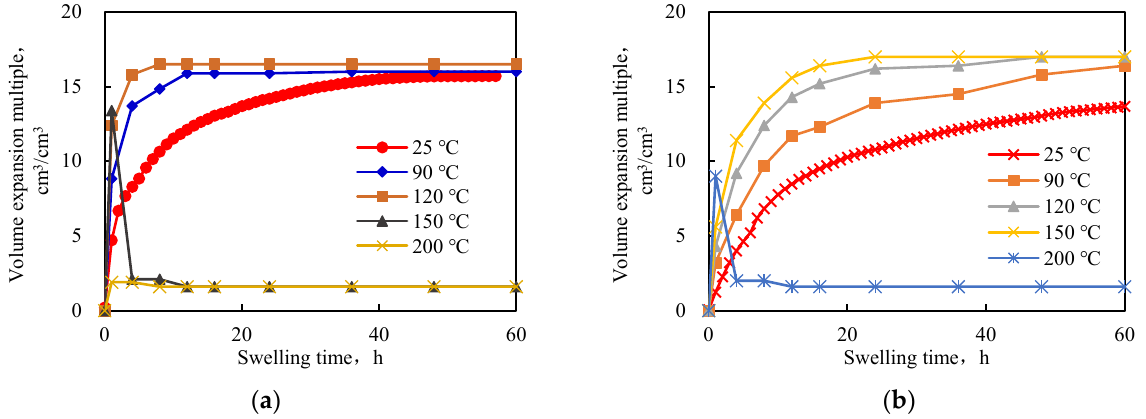
Figure 6. Curves for the swelling rates of the interpenetrating network aggregates at different temperatures: ( a ) PAM-gel; ( b ) IPN@sericite-gel.